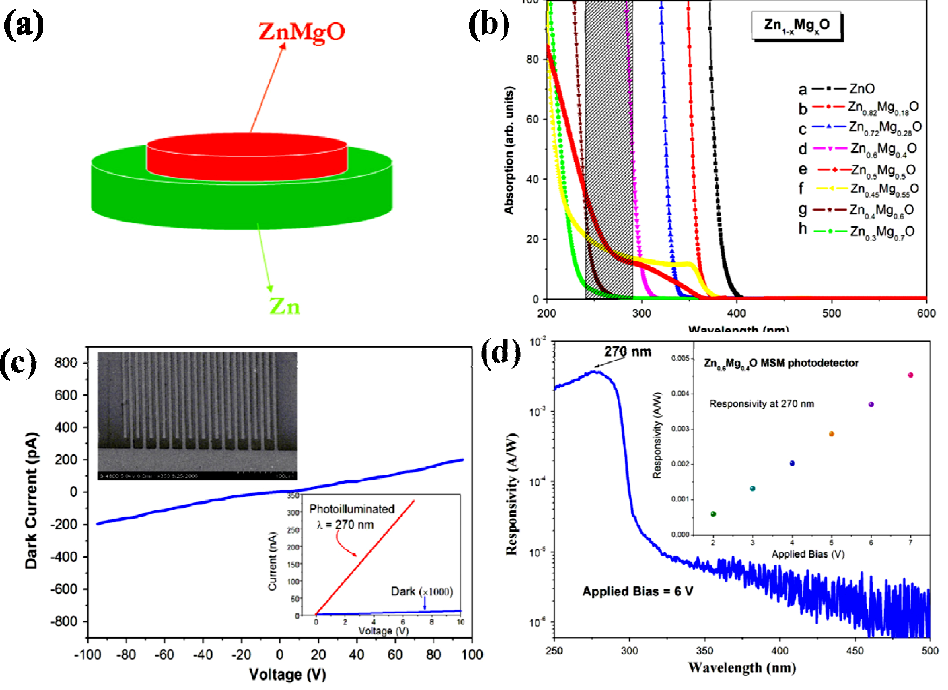
Figure 19. (a) The schematic diagram of the composite ZnMgO–Zn target. (b) The UV–visible absorption spectra of Zn Mg O films with different x values. (c) The typical 1−x x I – V characteristics of the Zn Mg O film based MSM detector (d) The spectral response 0 . 6 0 . 4 of the Zn Mg O UV detector with a 5 µ m finger pitch biased at 6V. The inset shows 0 . 6 0 . 4